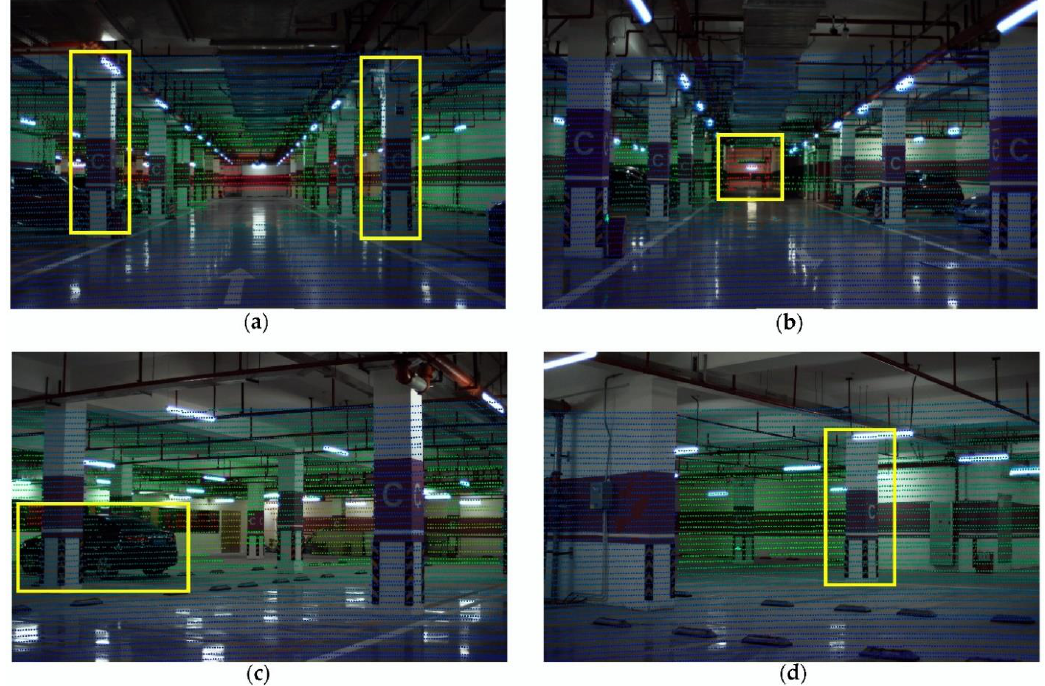
Figure 15. Results of outdoor scene test, 𝜃 = 0.2°. The contents in yellow rectangles in ( a - d ) are projections at different distances.